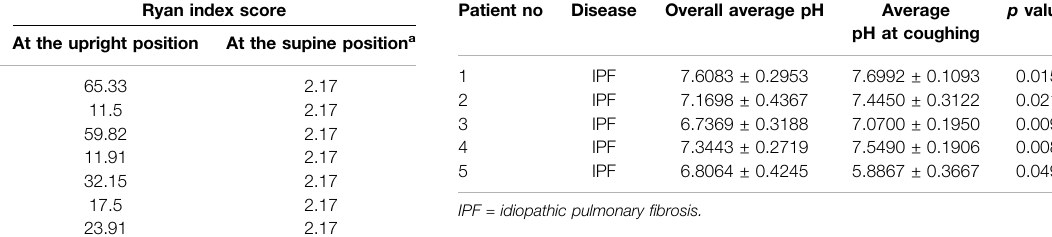
TABLE 5 | Seven patients showing abnormal Ryan index score. TABLE 6 | Five patients showing signi fi cant changes in pH values at coughing. Patient no Disease Ryan index score Patient no Disease Overall average At the upright position At the supine position a